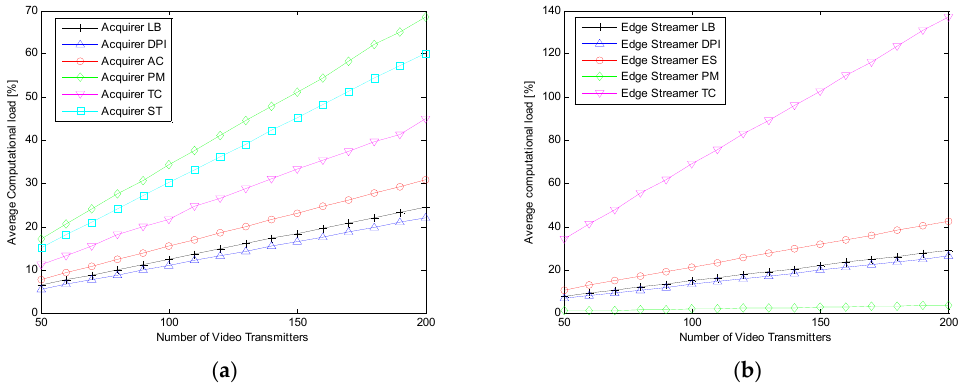
Figure 6. Average computational load. ( a ) acquirer blocks; ( b ) edge streamer blocks. LB: load balancer;